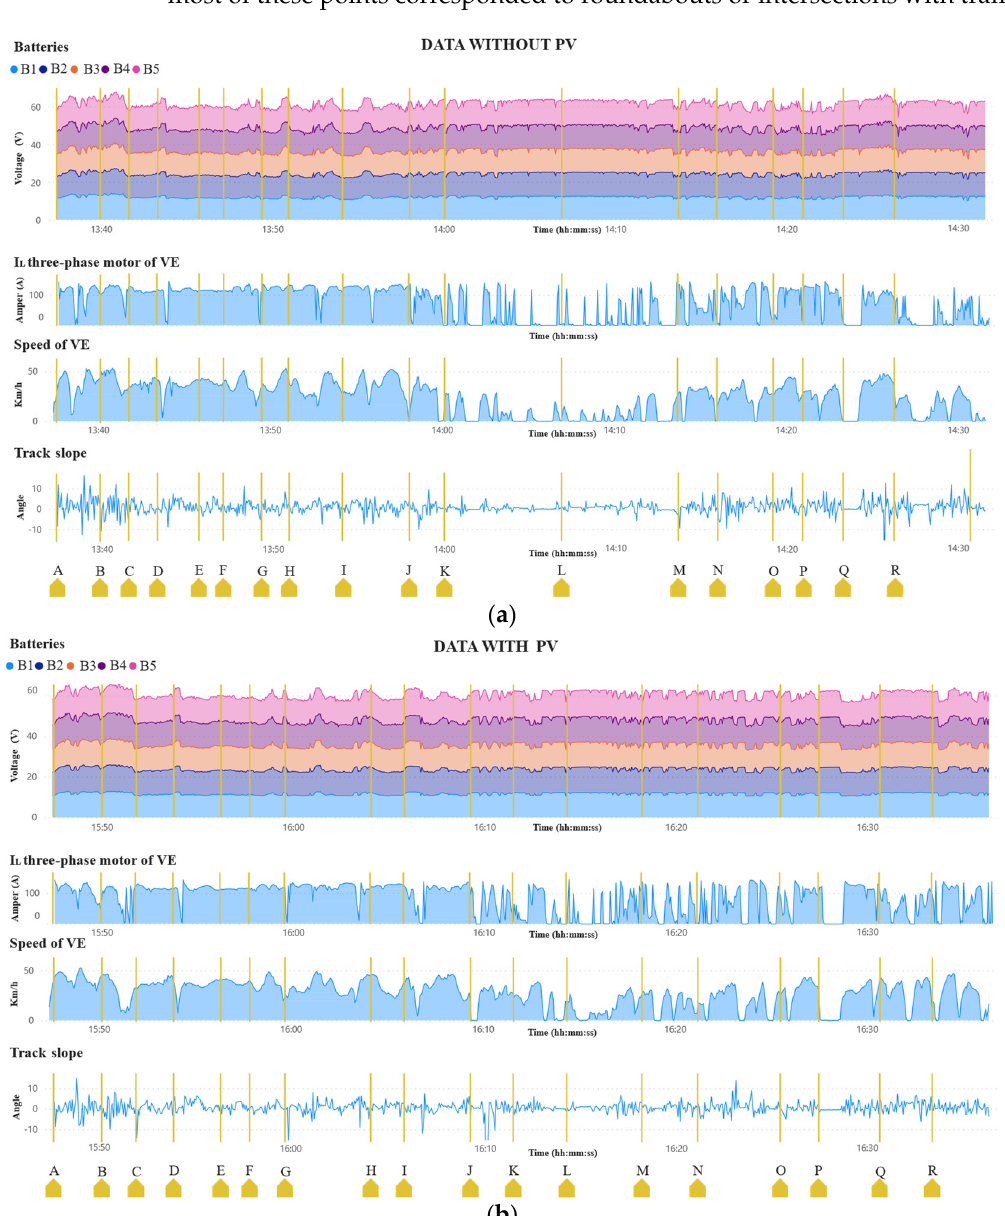
Figure 9. Data obtained for the EV trajectory: ( a ) without PV; ( b ) with PV.